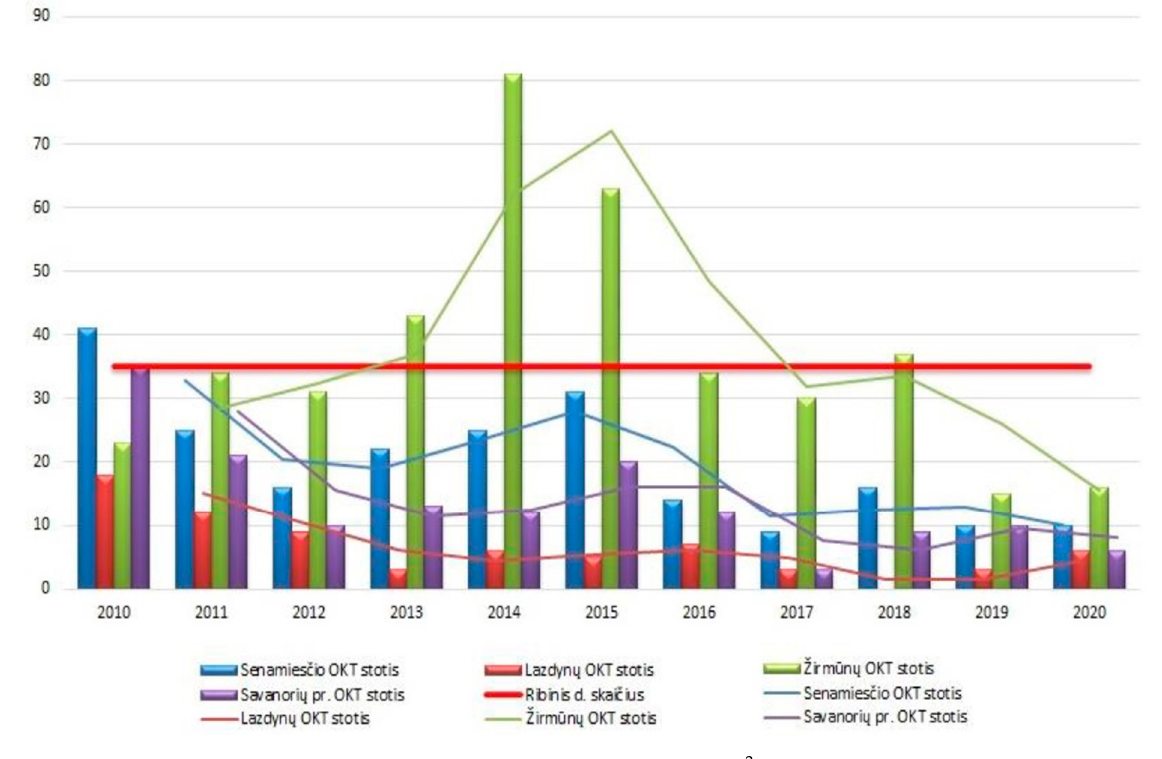
Figure 10. Exceedance days (for PM 10 > 25 ug/m 3 ).